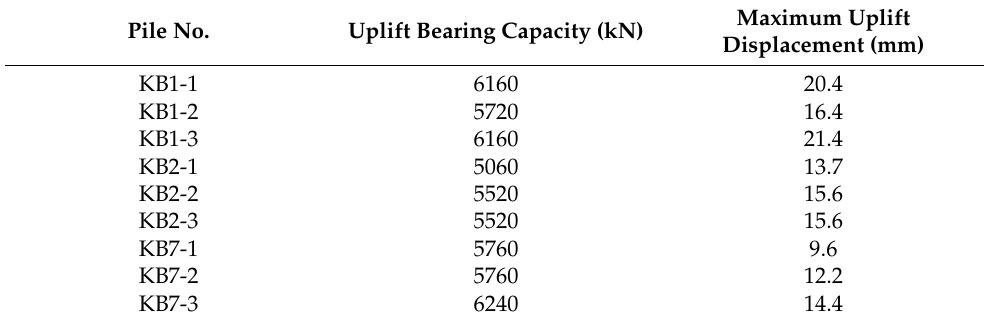
Table 2. Experimental results of test piles. Pile